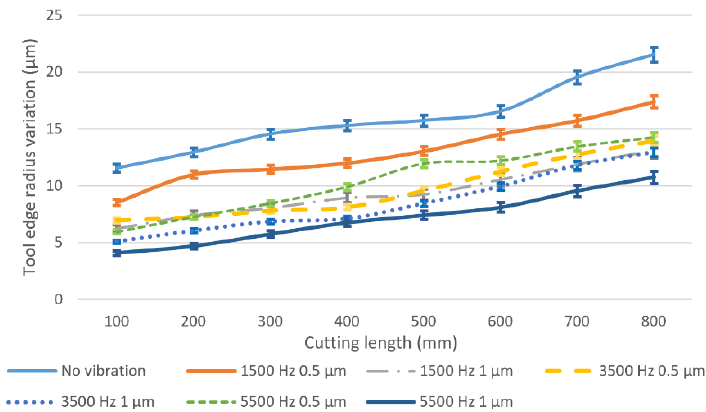
Figure 8. Tool edge radius variation under different vibration conditions and cutting length.